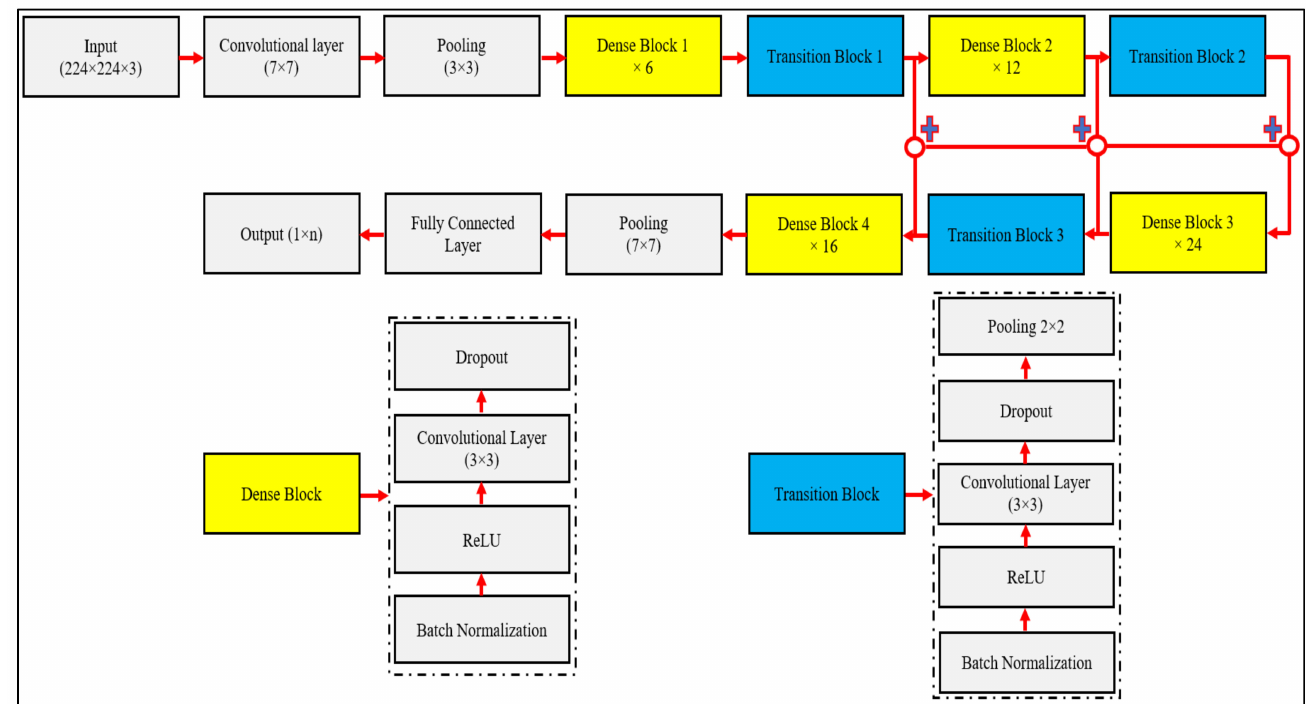
Figure 7. DenseNet-121 layered architecture where yellow block represents Dense Block; Blue Blocks represents Transition Block, from